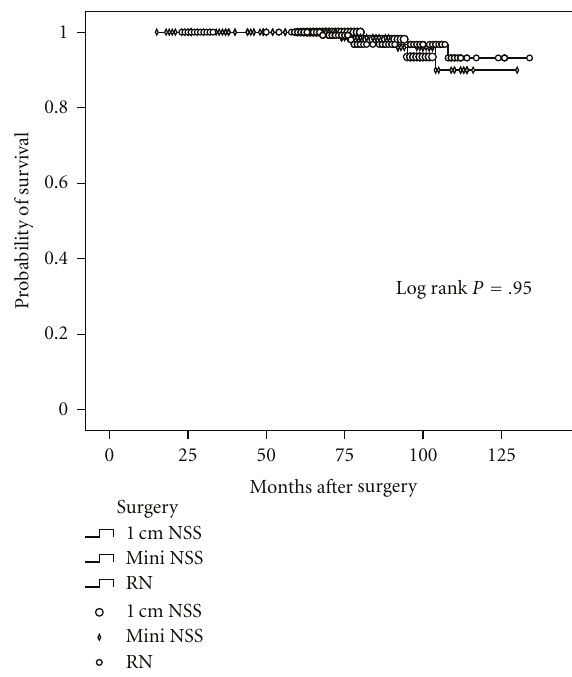
Figure 1: Overall survival for 135 patients treated with mm-NSS, 98 patients with 1cm-NSS and 156 patients with RN.